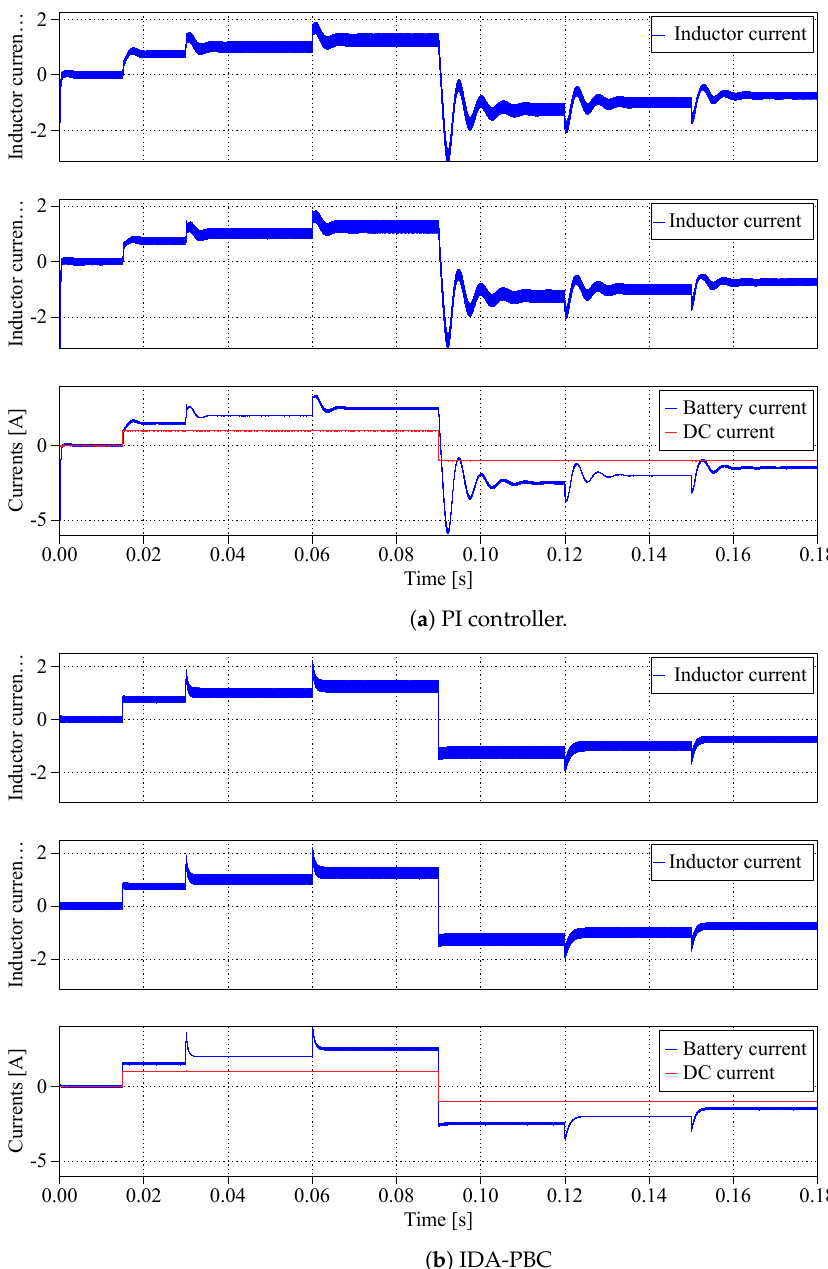
Figure 9. The dynamic response of currents associated with the interleaved boost converter under different DC voltage and current